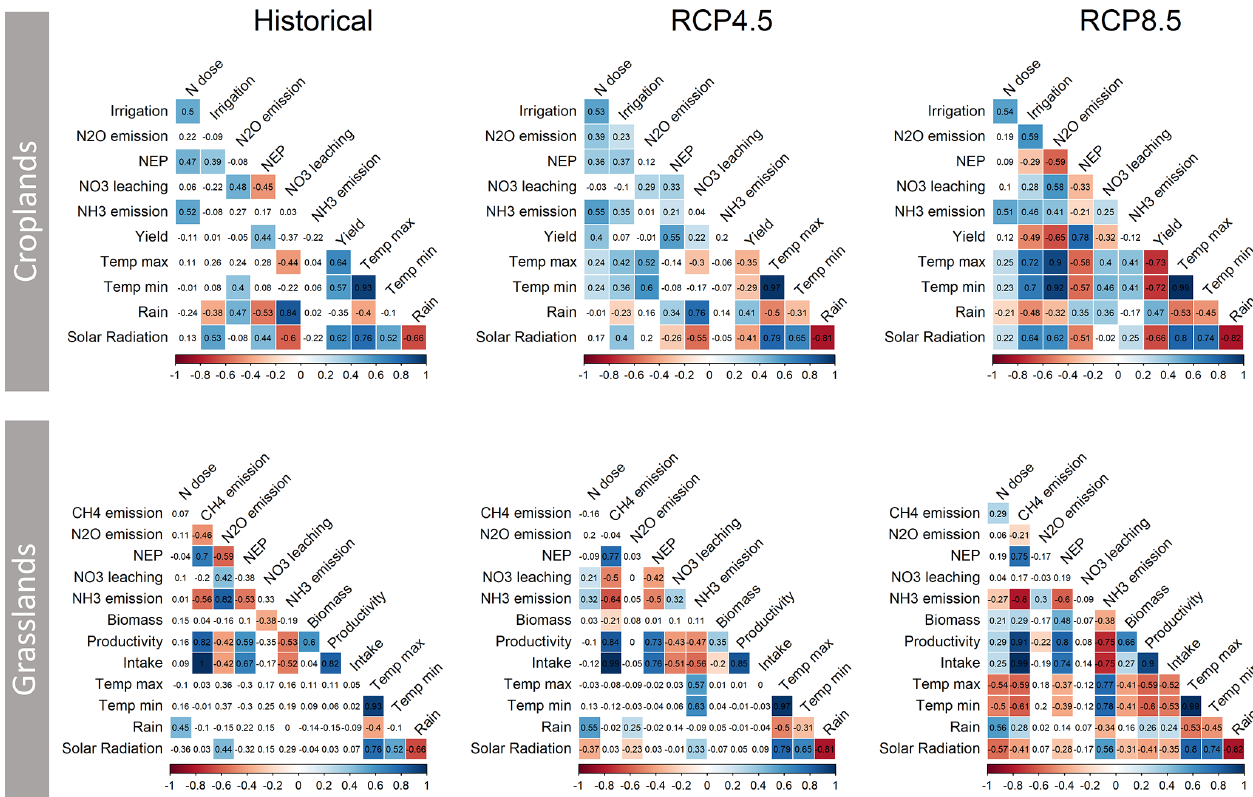
Figure 12. Correlation matrixes for croplands and grasslands considering the most interesting indicators for the objectives of this study. Correlation is presented for the historical period (1978–2004) and for the RCP4.5 and RCP8.5 scenarios. For croplands the irrigable scenario is shown here, while the results for the irrigated scenario are shown in Fig. S8. Coloured squares mean significant results ( p value <